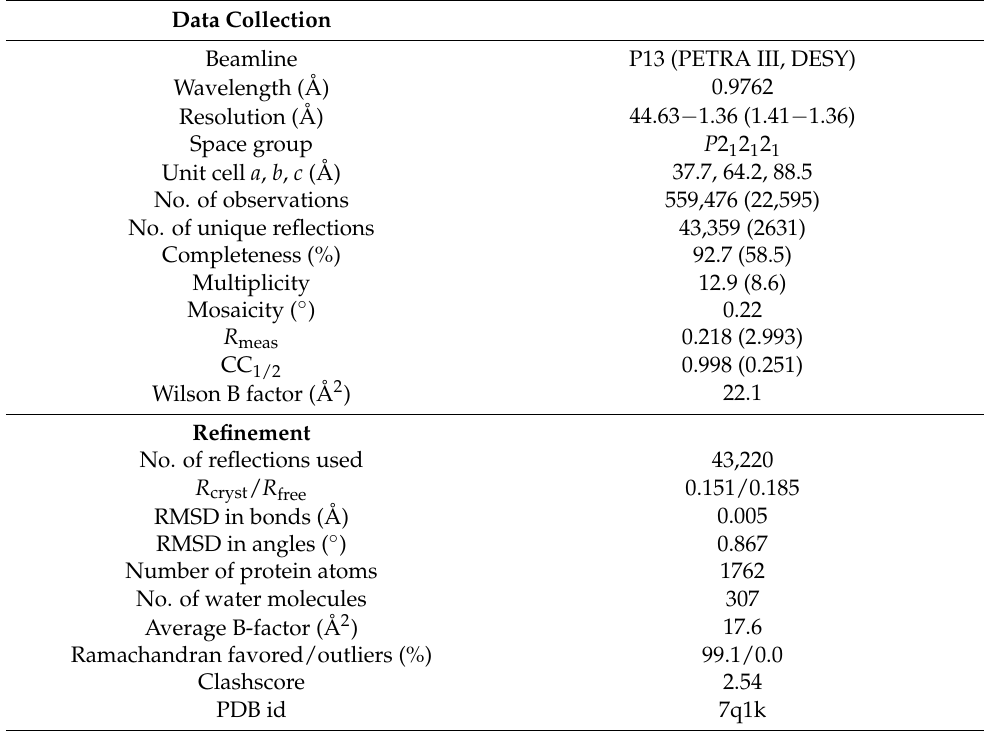
Table 1. X-ray data collection and refinement statistics. Numbers in parentheses refer to the outermost resolution